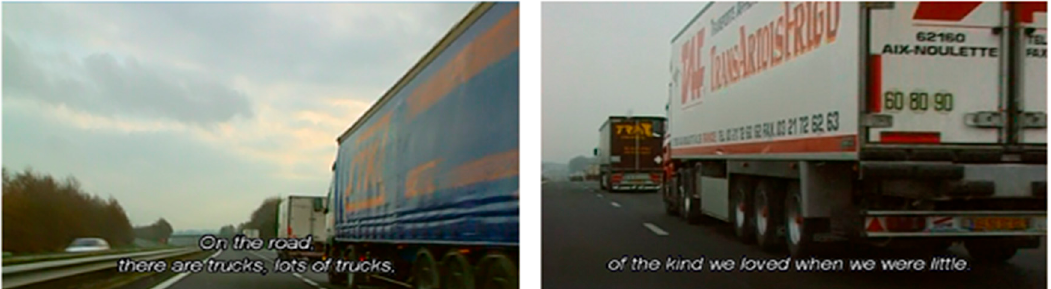
Figure 3. Trucks on the motorway, viewed from Varda’s car.